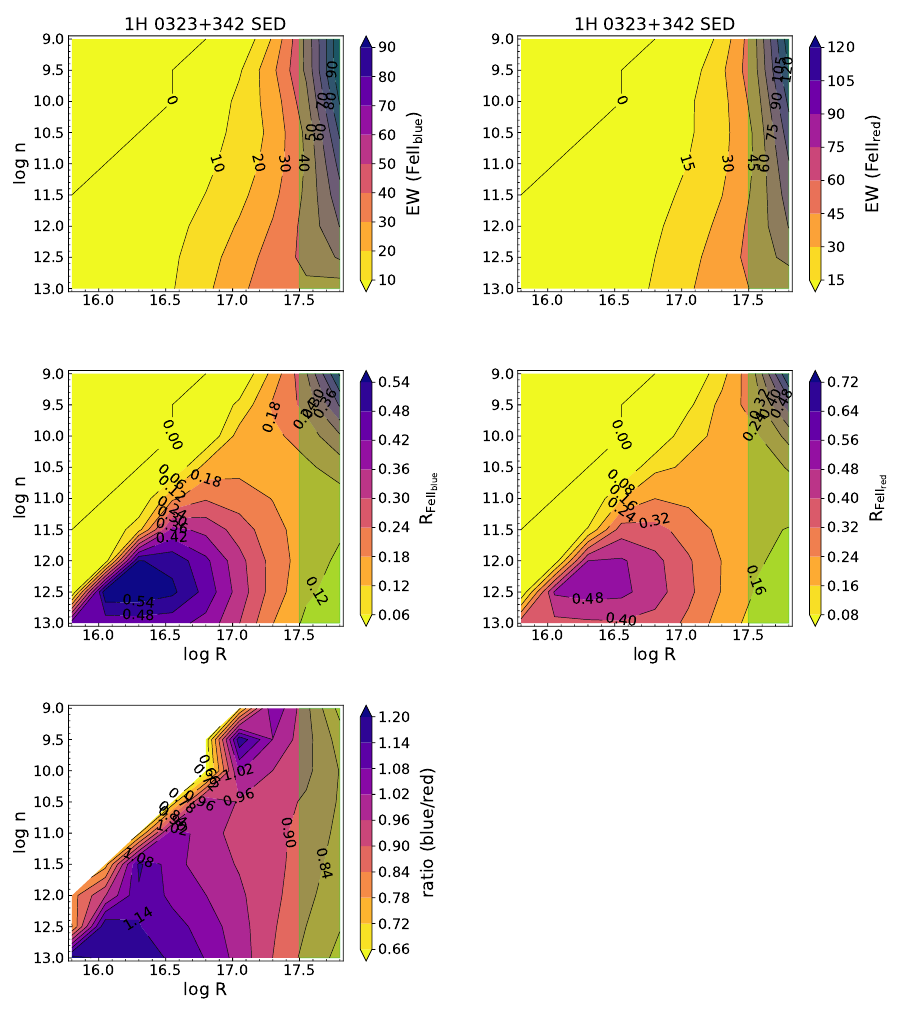
Figure 13. Results of CLOUDY simulations for the 1H 0323+342 SED: the two top panel yields the equivalent width of Fe II λ 4570 and the two middle panels R FeII for the blue and red blends, as a function of density and BLR radius. The bottom panel shows the ratio of the blue and red Fe II